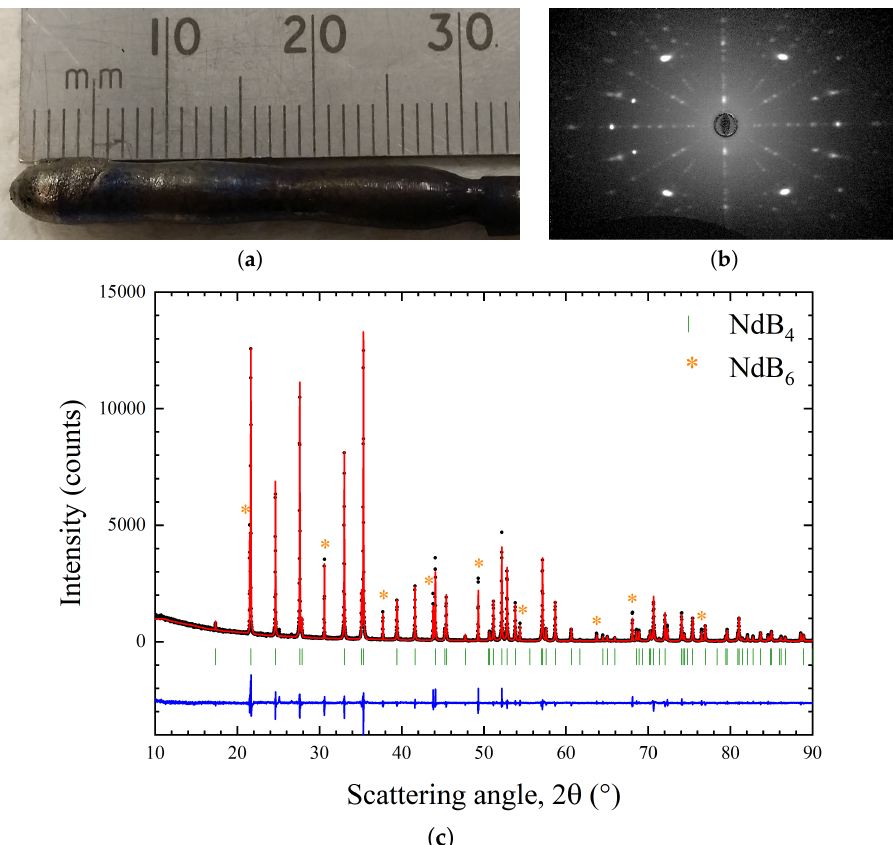
Figure 3. ( a ) Boule of NdB 4 prepared by the floating-zone method in an argon atmosphere at a growth rate of 15 mm/h. ( b ) X-ray Laue back reflection photograph of a crystal of NdB 4 , showing the [100] orientation of an aligned sample used for physical properties measurements. ( c ) Room temperature powder X-ray diffraction pattern of a ground NdB 4 crystal. The experimental profile (black closed circles) and a full profile matching refinement (red solid line) made using the P 4/ mbm tetragonal structure are shown, with the difference given by the blue solid line. The symbols * indicate the reflections belonging to a NdB 6